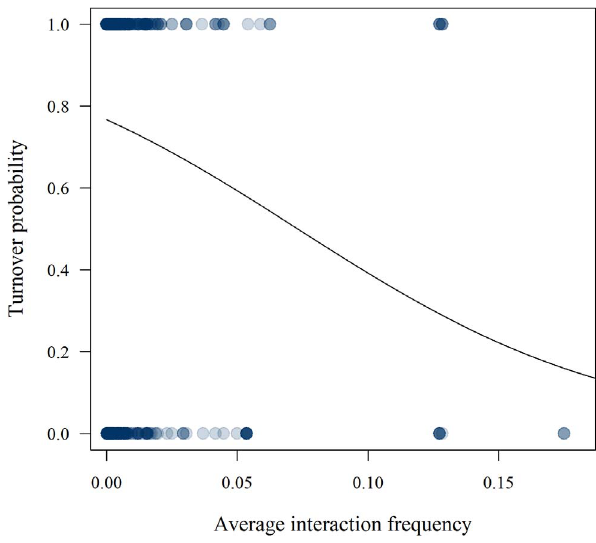
Figure 4. Flower abundance and the probability of losing an interaction. Whether pairwise interactions are realized or not is highly dependent on local flower abundance of the plant species. The figure shows the increasing probability of losing an interaction when going from a site with higher local flower abundance of the plant species to a site with lower local flower abundance. The larger the difference in local flower abundance, the stronger the effect. Superimposed points result in darker